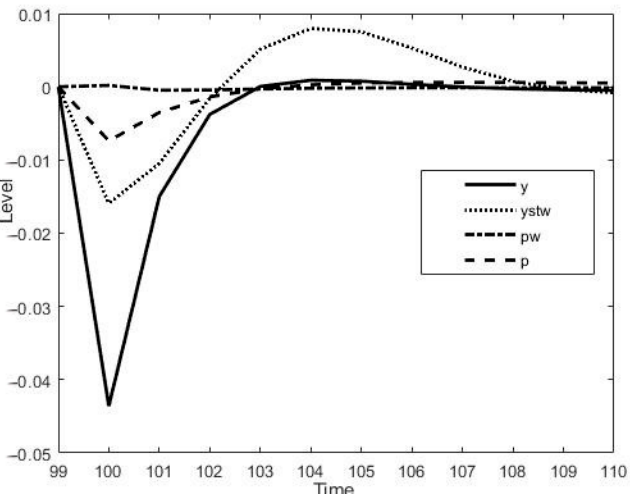
Figure 5. The impact of a positive technology shock on the variables of the behavioral model with an imperfect labor market (pw is wage inflation; ystw is the output gap) and on the variables of the model with flexible wages and rigid prices ( p is price inflation, y is the output gap). The shock value is equal to one standard deviation.